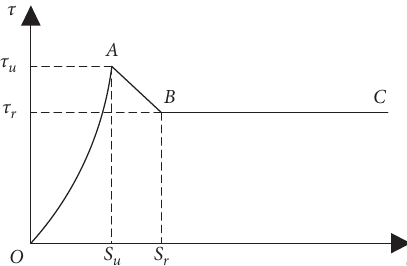
Figure 21: Simplified model for the τ − s curve of internal threads specimens.